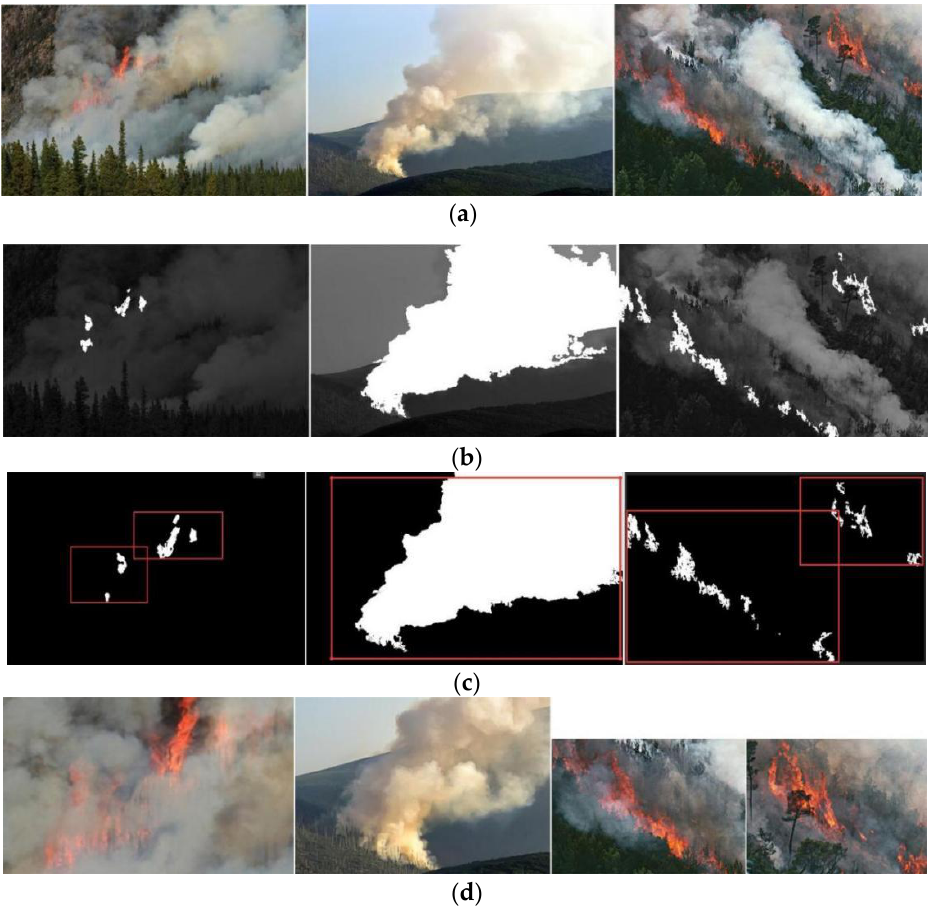
Figure 2. Image segmentation based on saliency detection. ( a ) Original images; ( b ) significance test results; ( c ) ROI selection results; and ( d ) standard segmentation results. results; ( c ) ROI selection results; and ( d ) standard segmentation